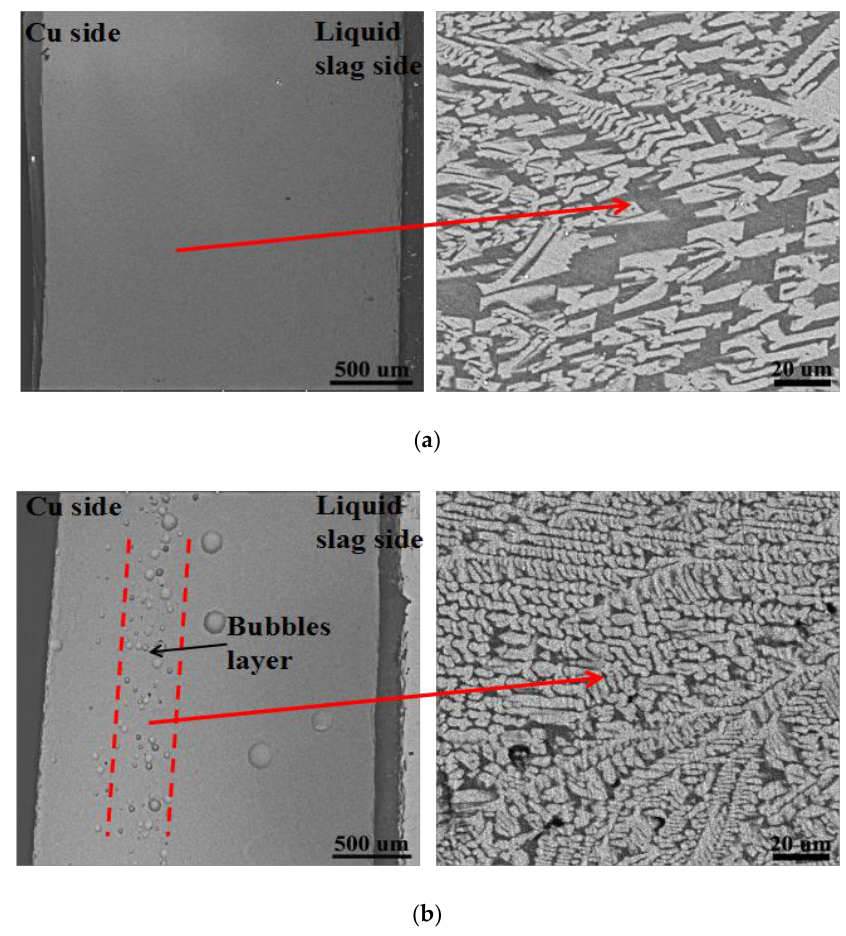
Figure 5. Overall image (left) and microstructure image (right) of slag films. ( a ) A slag film; ( b ) B1 slag film.